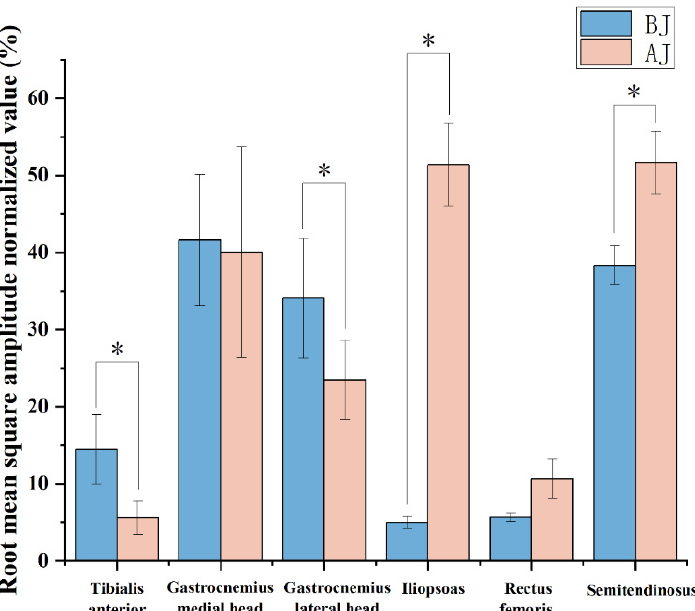
Figure 5. The mean electromyography (EMG) data of lower limb muscles through the ground-contact phase. Note: * represents a significant difference between bounced jump (BJ) and alternate jump (AJ), p < 0.05.